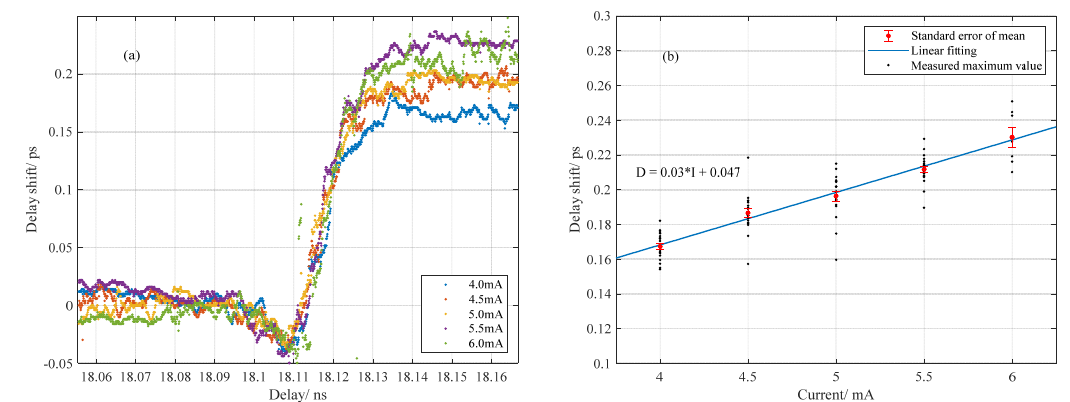
Figure 6. ( a ) Variation of delay shift with different current; ( b ) relationship between delay shift (equivalent change of OPL) and applied discharge currents.